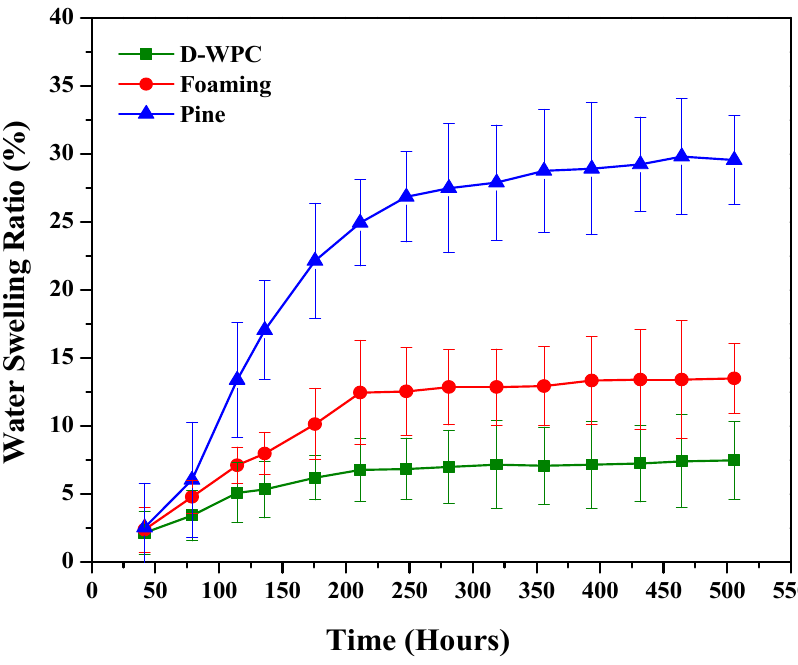
Figure 9. The effect on water swelling ratio with time for different types of wood fibre.